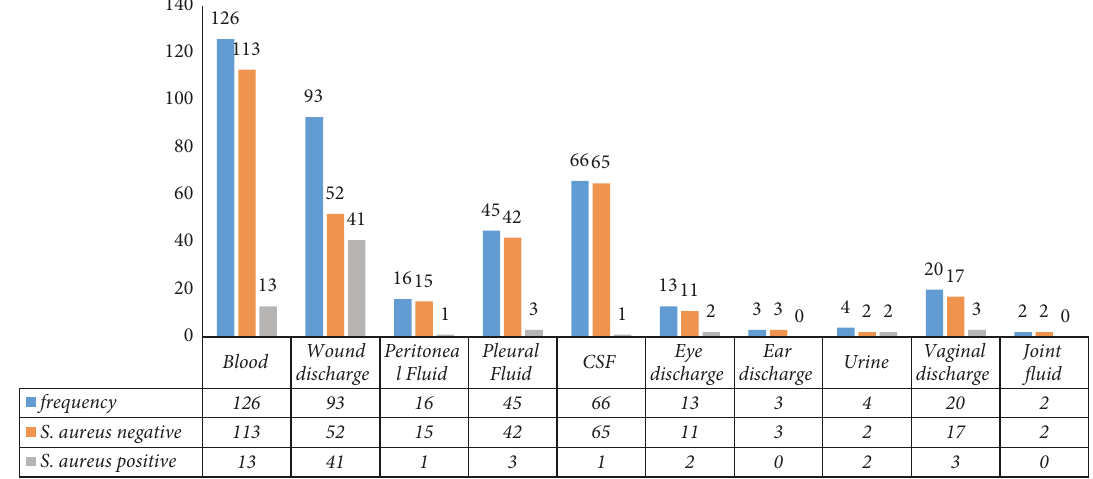
Figure 1: Frequency of Staphylococcus aureus isolates by clinical samples among patients attending University of Gondar Comprehensive Specialized Hospital, Ethiopia, 2018. CSF: cerebrospinal fluid.